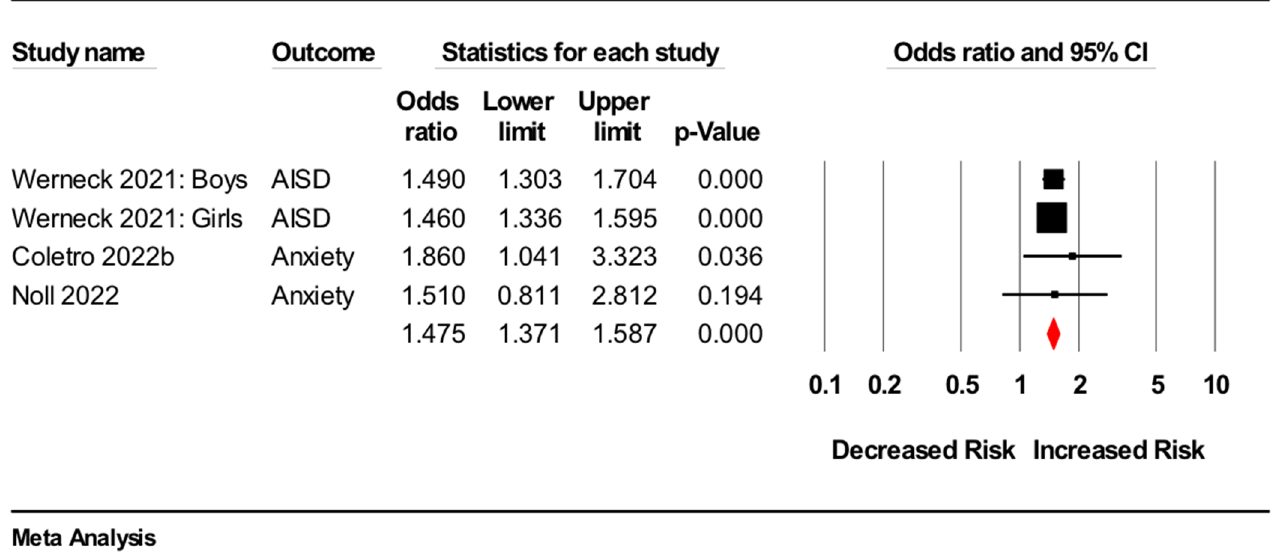
Figure 3. Forest plot of meta-analysis for cross-sectional studies assessing associations between higher versus lower consumption of ultra-processed food and odds of anxiety symptoms [21,24,25]. Note: AISD: anxiety-induced sleep